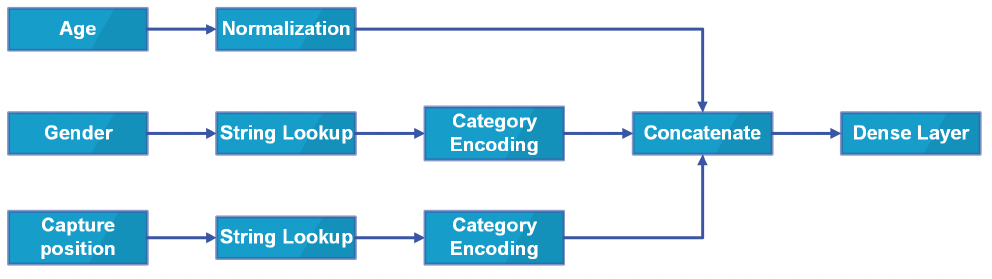
Figure 5. Input schema.